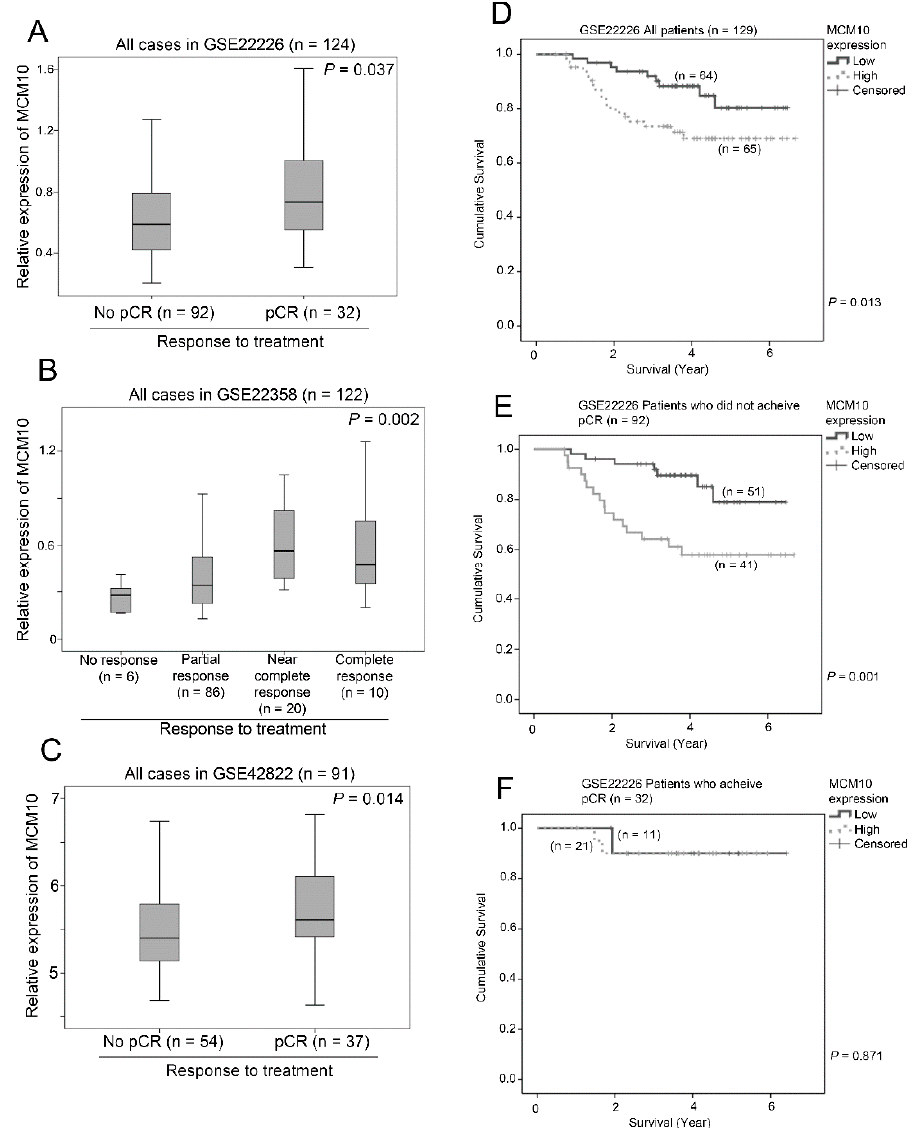
Figure 7. The association between MCM10 expression and response to neoadjuvant chemotherapy. Box plots showing the mean, 95% confidence interval and range of MCM10 mRNA expression in breast cancer datasets in patients with various response to chemotherapy in ( A ) GSE 22226 ( n = 124); ( B ) GSE22358 ( n = 122) and ( C ) GSE42822 ( n = 91). Kaplan-Meier plots showing proportion of patients survived for those with low or high level expression of MCM10 in GSE22226; ( D ) the whole patient cohort; ( E ) patients who did not achieve pCR and ( F ) patients who achieved pCR.